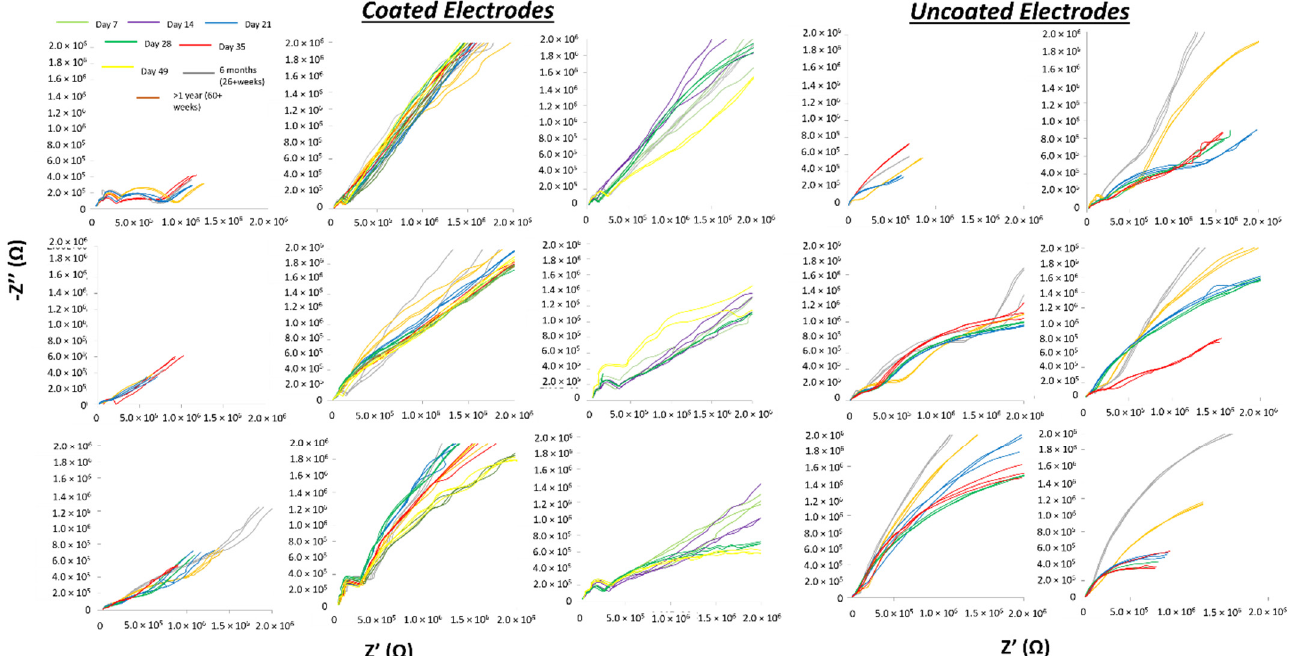
Figure 6. Nyquist plots of coated ( n = 9 electrodes) and uncoated electrodes ( n = 6) from 5 animals are shown over 5–7 weeks of implantation. Soft-coated electrodes show relative stability in electrical impedance after the first week over long implantation periods compared to 4 of 6 uncoated electrodes.